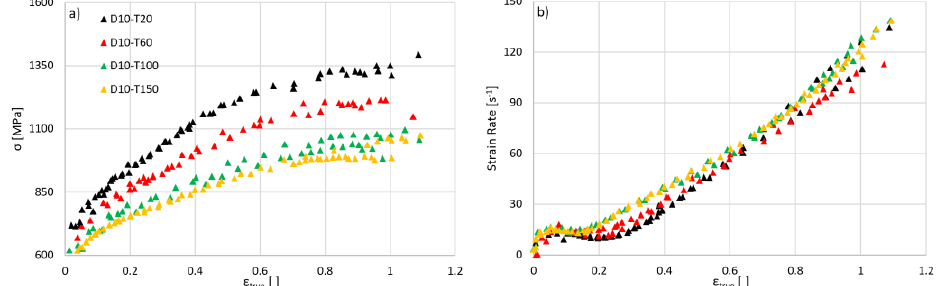
Fig. 3. Tests at the same strain rate (10 s -1 ) and different initial temperatures: (a) true stress-strain curves; (b) Strain rate-strain